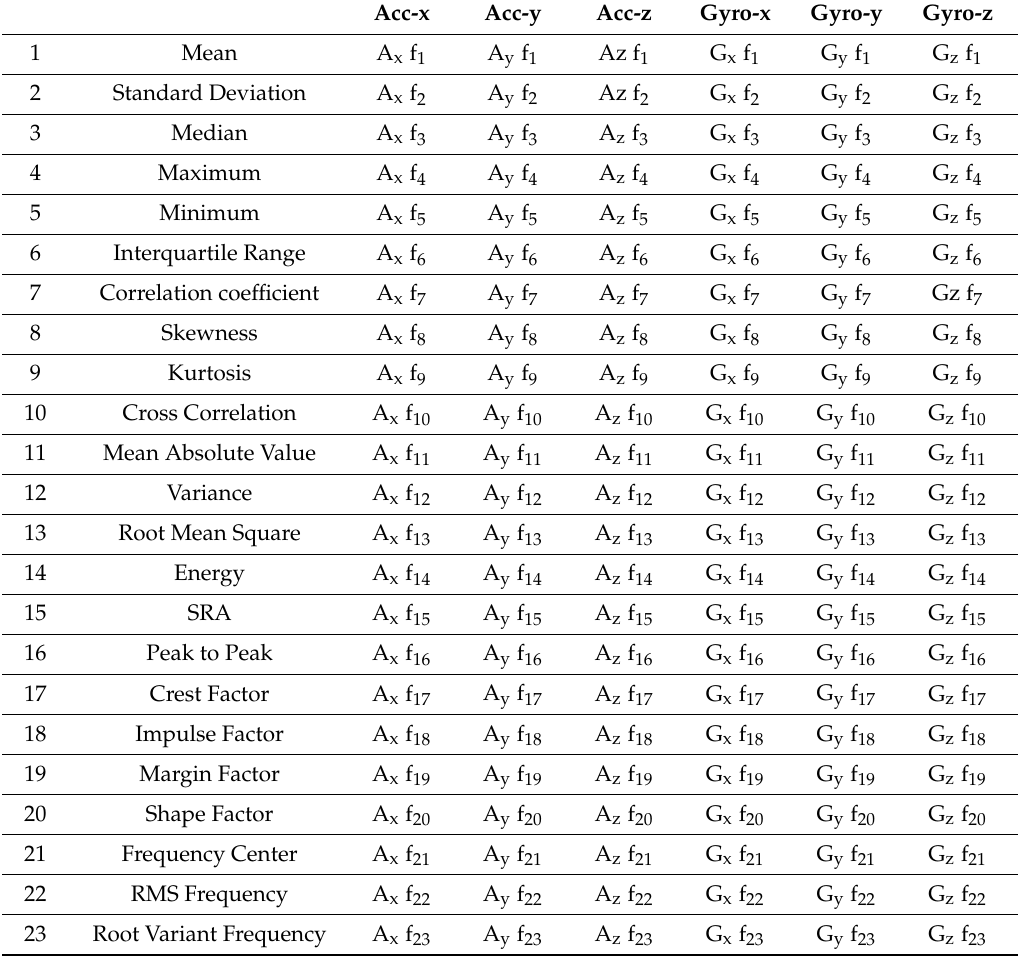
Table 2. Original feature vector.